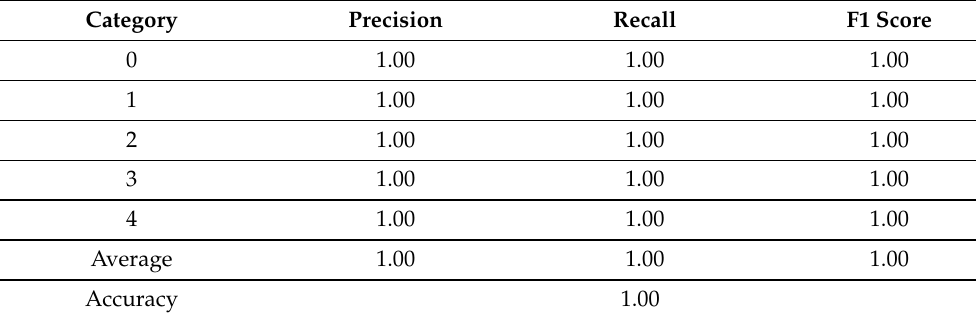
Table 14. Results for the proposed XGB as classification model for multi-omics and high dimensional real genomic dataset.